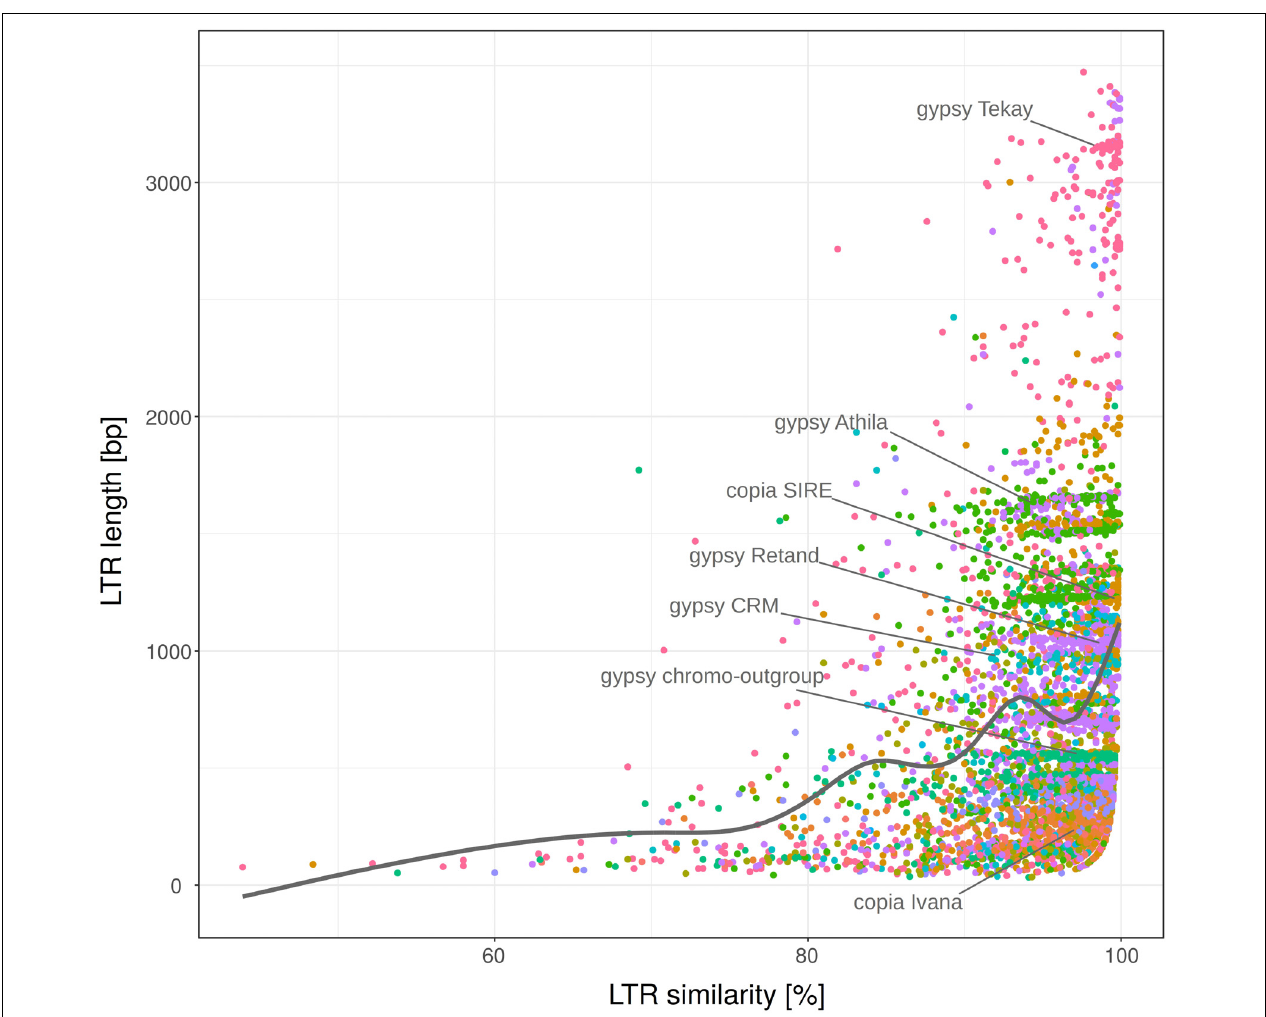
FIGURE 5 | LTR length plotted against 5 (cid:48) -3 (cid:48) LTR similarity. LTR retrotransposon families (labeled with different colors) of fifteen plant species. Nested, original and non-nested LTR retrotransposons were analyzed together. Full set of 25,144 elements was randomly sampled to subset with n = 5000. Most abundant families are labeled within the